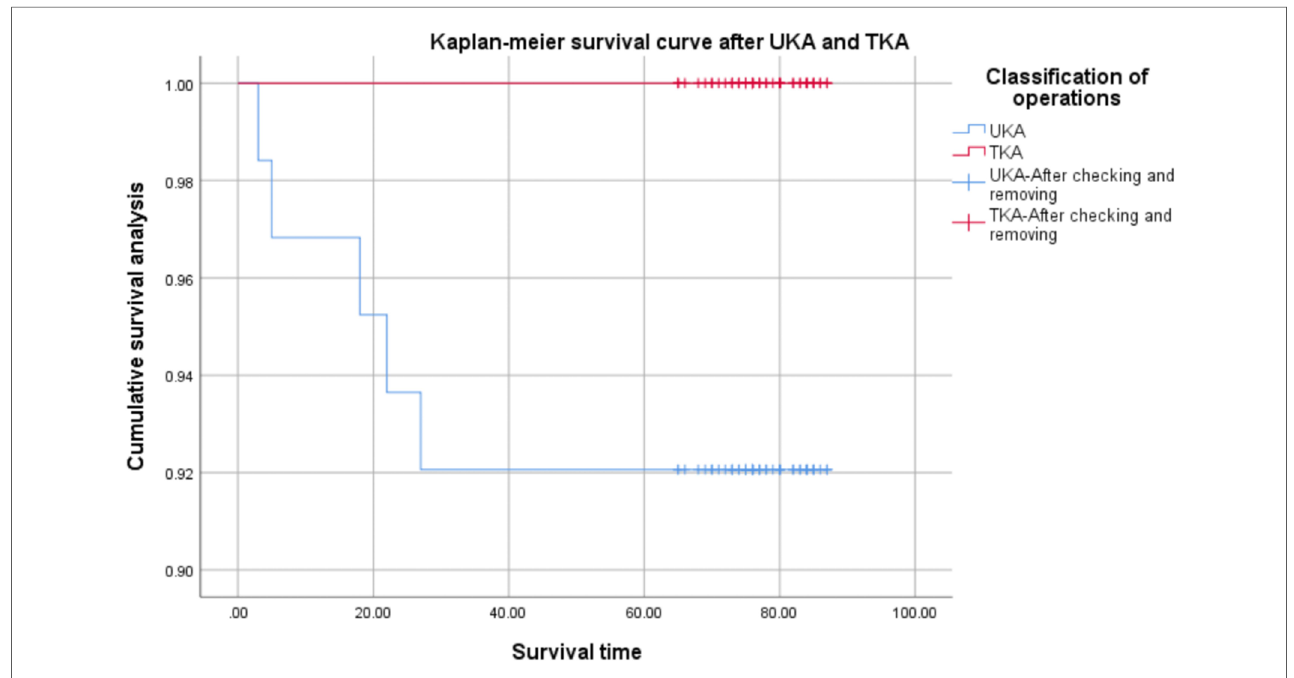
FIGURE 2 Survival curves of kaplan-Meier prosthesis in two